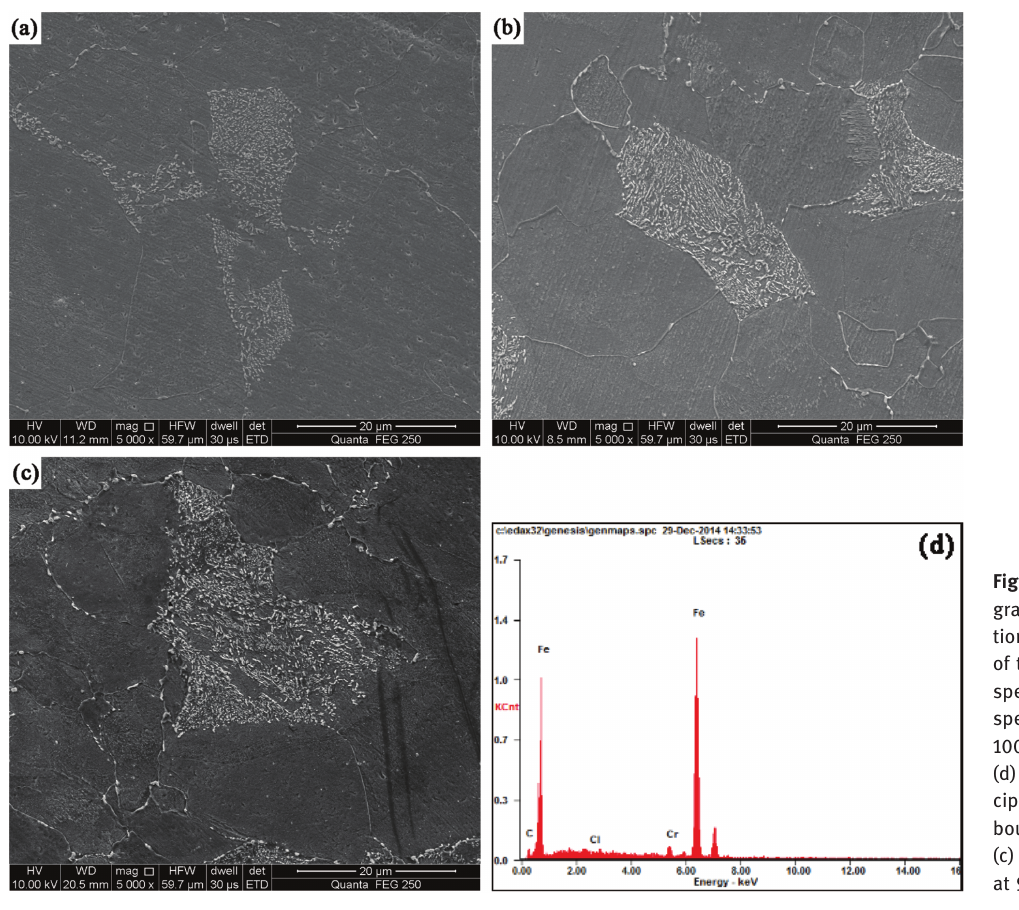
Table 8: Composition of grain boundaries in the transitional area of the corrosive specimen (973.15K/100MPa). Grain boundaries Element